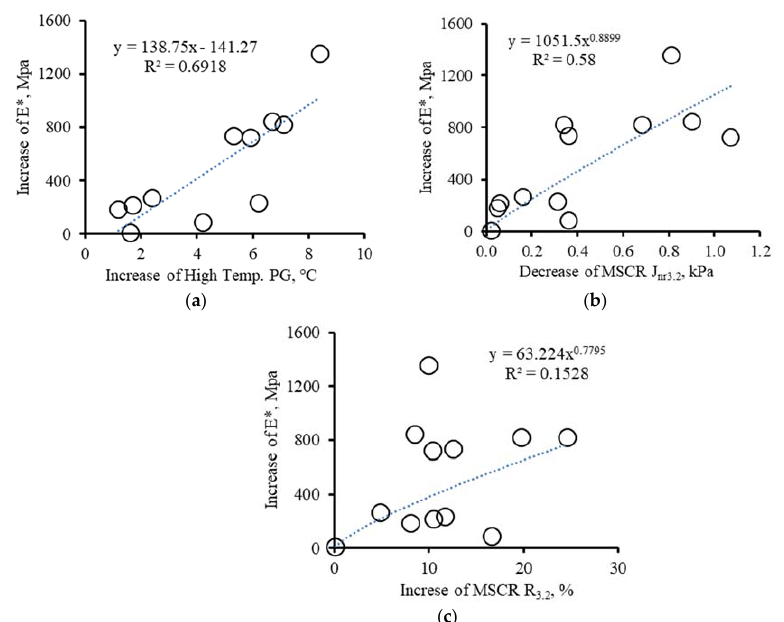
Figure 8. Effect of asphalt binder property change on dynamic modulus change ( a ) increase in high-temperature PG, ( b ) decrease in MSCR Jnr3.2 and ( c ) increase in MSCR R3.2 . Figure 9 shows the relationship between the binder property change and HWT rut depth. As noted, there was a loose relationship denoting that rut depth in general in- creased with the increase in high-temperature PG and decrease in MSCR Jnr3.2 . No cor- relation between HWT rut depth and MSCR R3.2 over time was found. As it can be seen, the increase in high-temperature PG (1.2 to 8.4 °C) and the decrease in MSCR Jnr3.2 (0.02 to 1.07 kPa) reduced the HWT rut depth to the maximum value of 7.3mm between the two rounds.